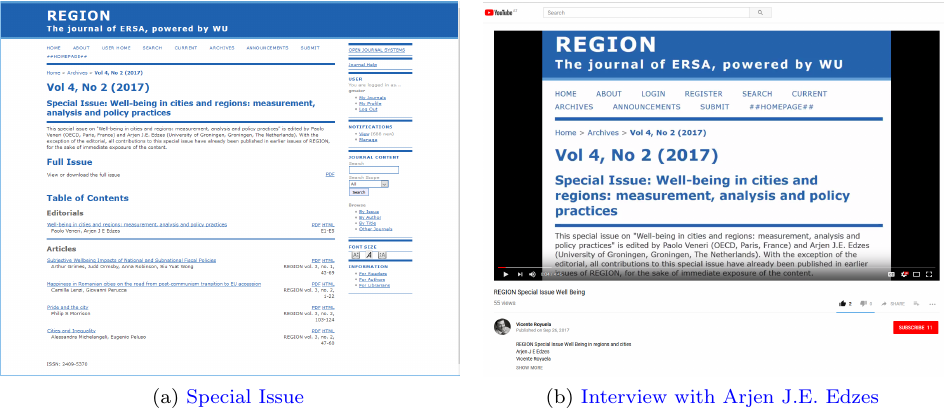
Figure 2: Special Issue on “Well-being in cities and regions: measurement, analysis and policy practices” (Click the figure or subheading to follow the respective link) it gets published immediately. Consequently, faster authors are not held back by the slower ones. Once the last Special Issue paper is published, we bundle them and a volume editorial together into a separate volume advertising the published papers, which are referenced to their original issue: “all contributions to this special issue have already been published in earlier issues of REGION, for the sake of immediate exposure of the content.” We believe that authors, special issue editors as well as the journal benefit from this policy. Right now REGION has published its first Special Issue as Volume 4 number 2 on “Well-being in cities and regions: measurement, analysis and policy practices”, edited by Paolo Veneri (OECD) and Arjen J.E. Edzes (University of Groningen) and we have also published papers from several other Special Issues and some new calls are open. We welcome new